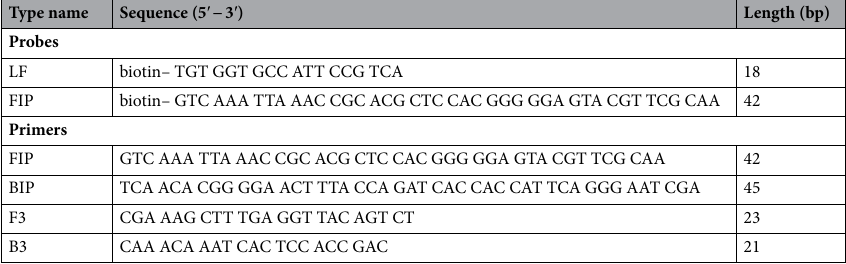
Table 2. Biotin-LAMP probe and LAMP primer sequences (Sriworarat et al. 11 ) used in this